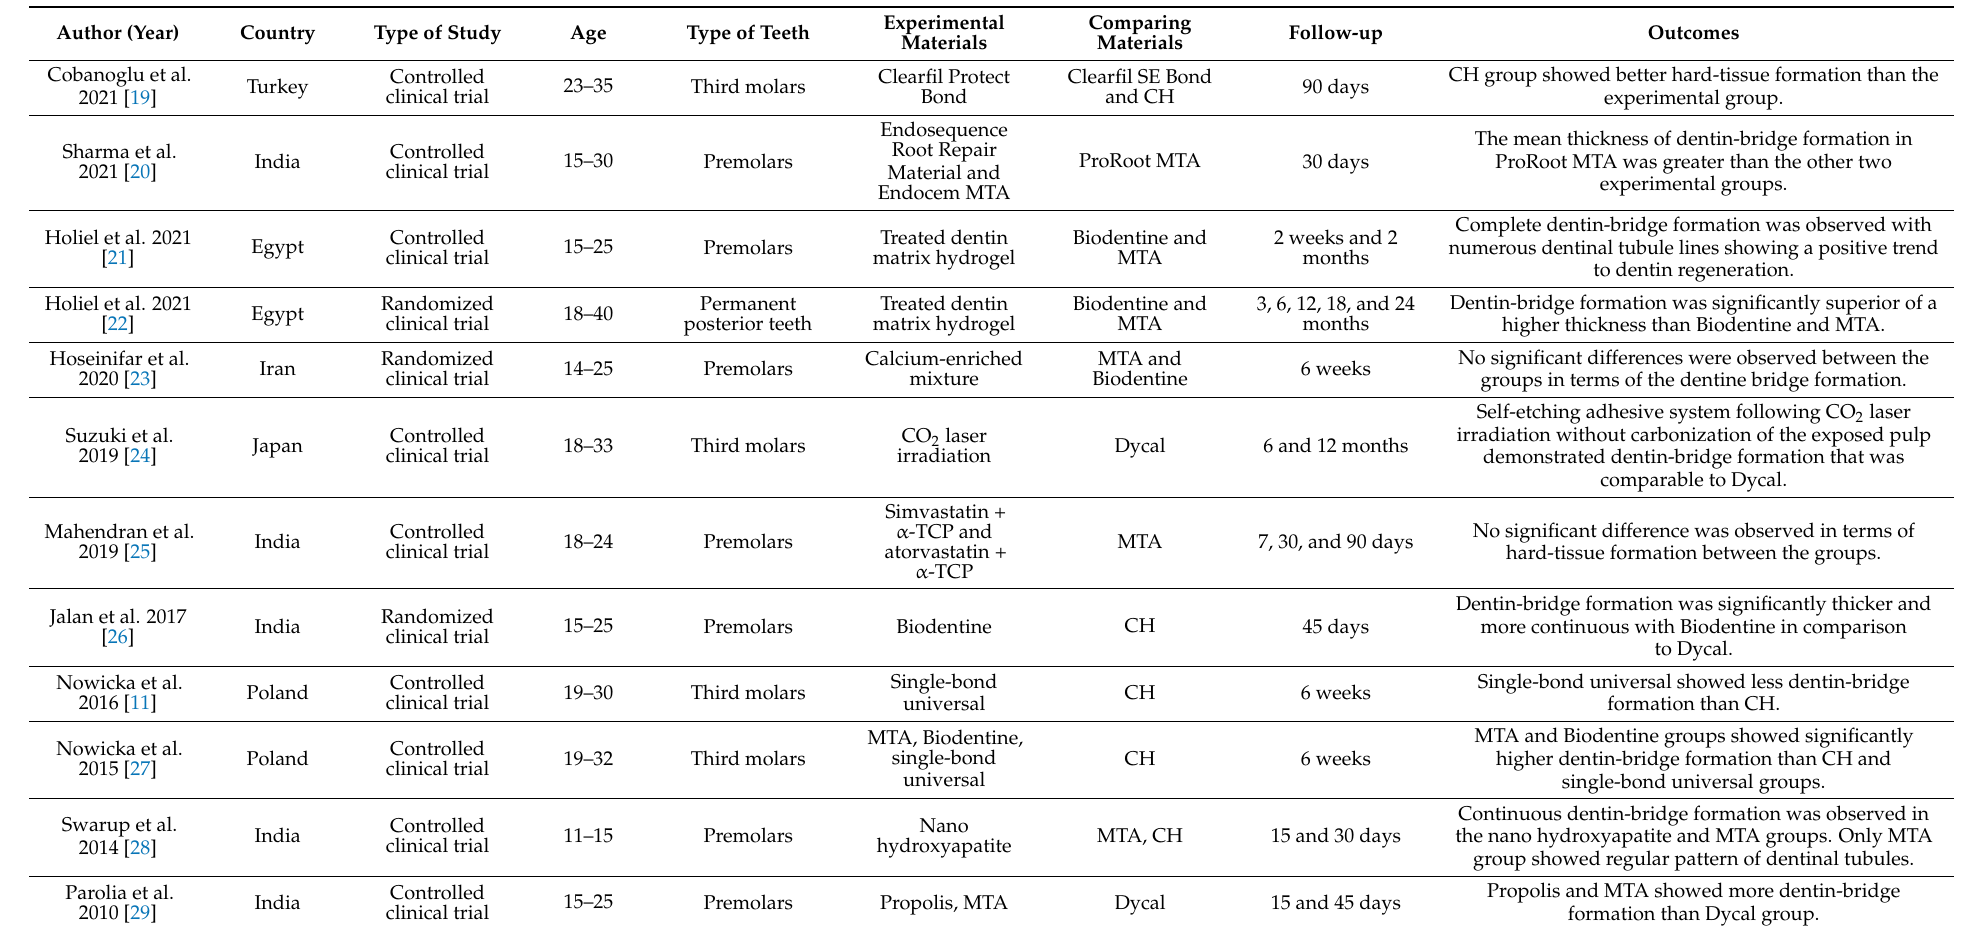
Table 1. Characteristic of the studies included (humans) in the systematic